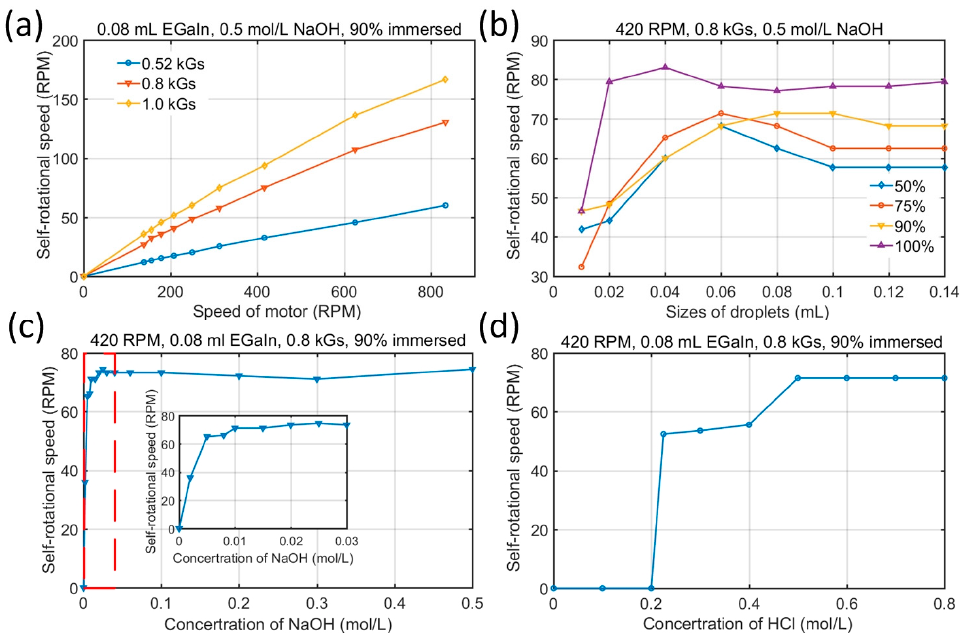
Figure 2. Change of the self-rotational performance under different operating parameters. ( a ) Self-rotational speed vs. speed of the motor plot; blue, red, and yellow curves indicate different magnetic field densities at the center of EGaIn droplets, respectively. ( b ) Self-rotational speed vs. sizes of droplets plot; blue, red, yellow, and purple curves indicate different depths of EGaIn droplet immersion in the NaOH solution, respectively. ( c ) Self-rotational speed vs. concentration of NaOH plot. ( d ) Self-rotational speed vs. concentration of HCl plot.